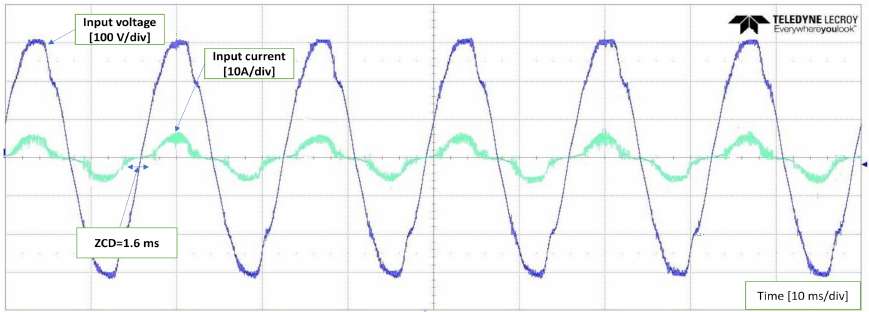
Figure 36. Experimental waveforms of the supply voltage-current with the proposed IP controller.